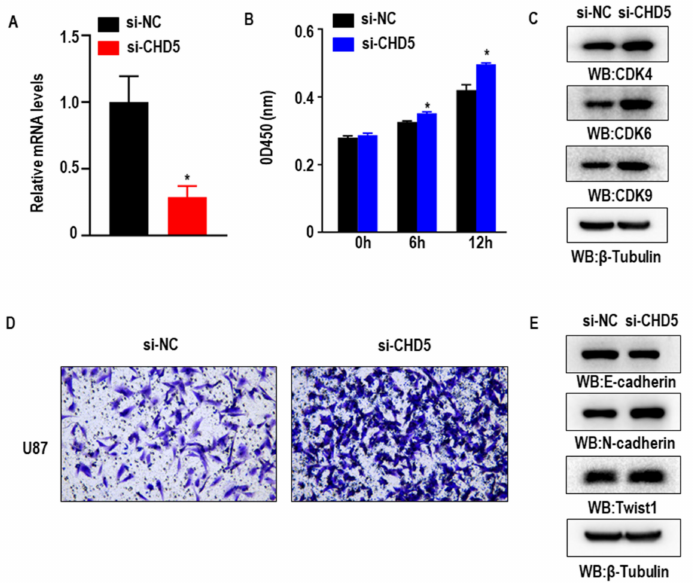
Figure 7. Cellular functions of CHD5. ( A ) Real-time quantitative PCR detection after siRNA mediated knockdown of CHD5 in U87 cells. ( B , C ) CCK-8 assay results showing the increase in the viability of U87 cells upon the knockdown of CHD5 . ( D , E ) Transwell assay results showing the increase in the migration and EMT progression in U87 cells upon the knockdown of CHD5 . * p <